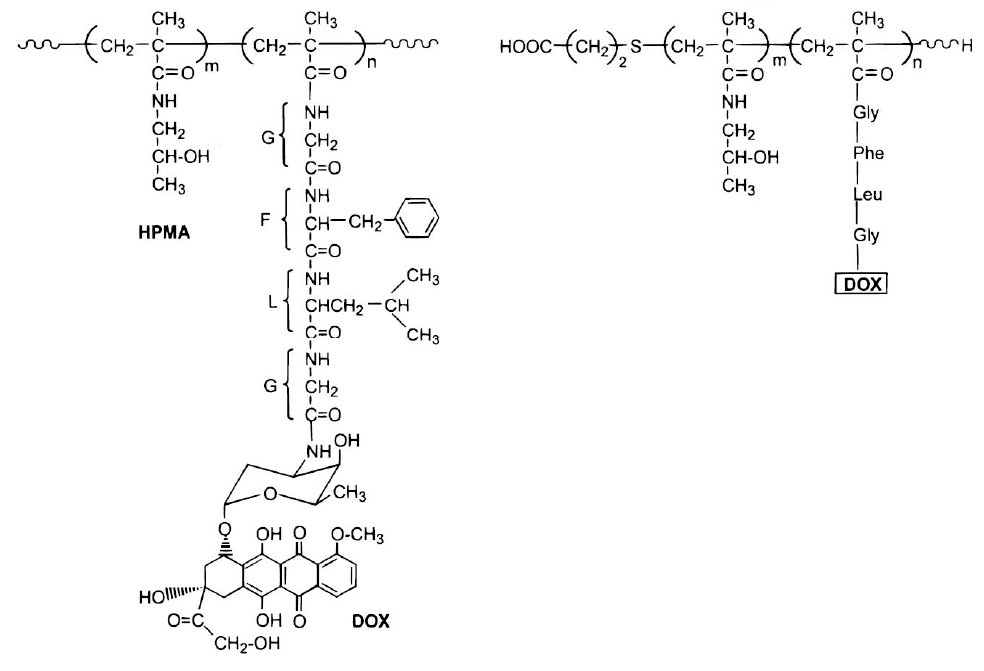
Figure 1. Structure of cathepsin-responsive HPMA copolymer drug conjugates: left, P(GFLG)-DOX; right, ST-PHPMA-DOX-COOH. Reproduced from ref. [118] with permission from the American Chemical Society.